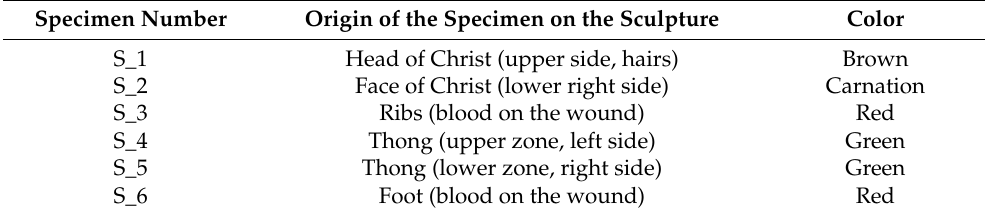
Table 1. Labels, and origin of the specimen on the sculpture and its dominant color. Specimen Number